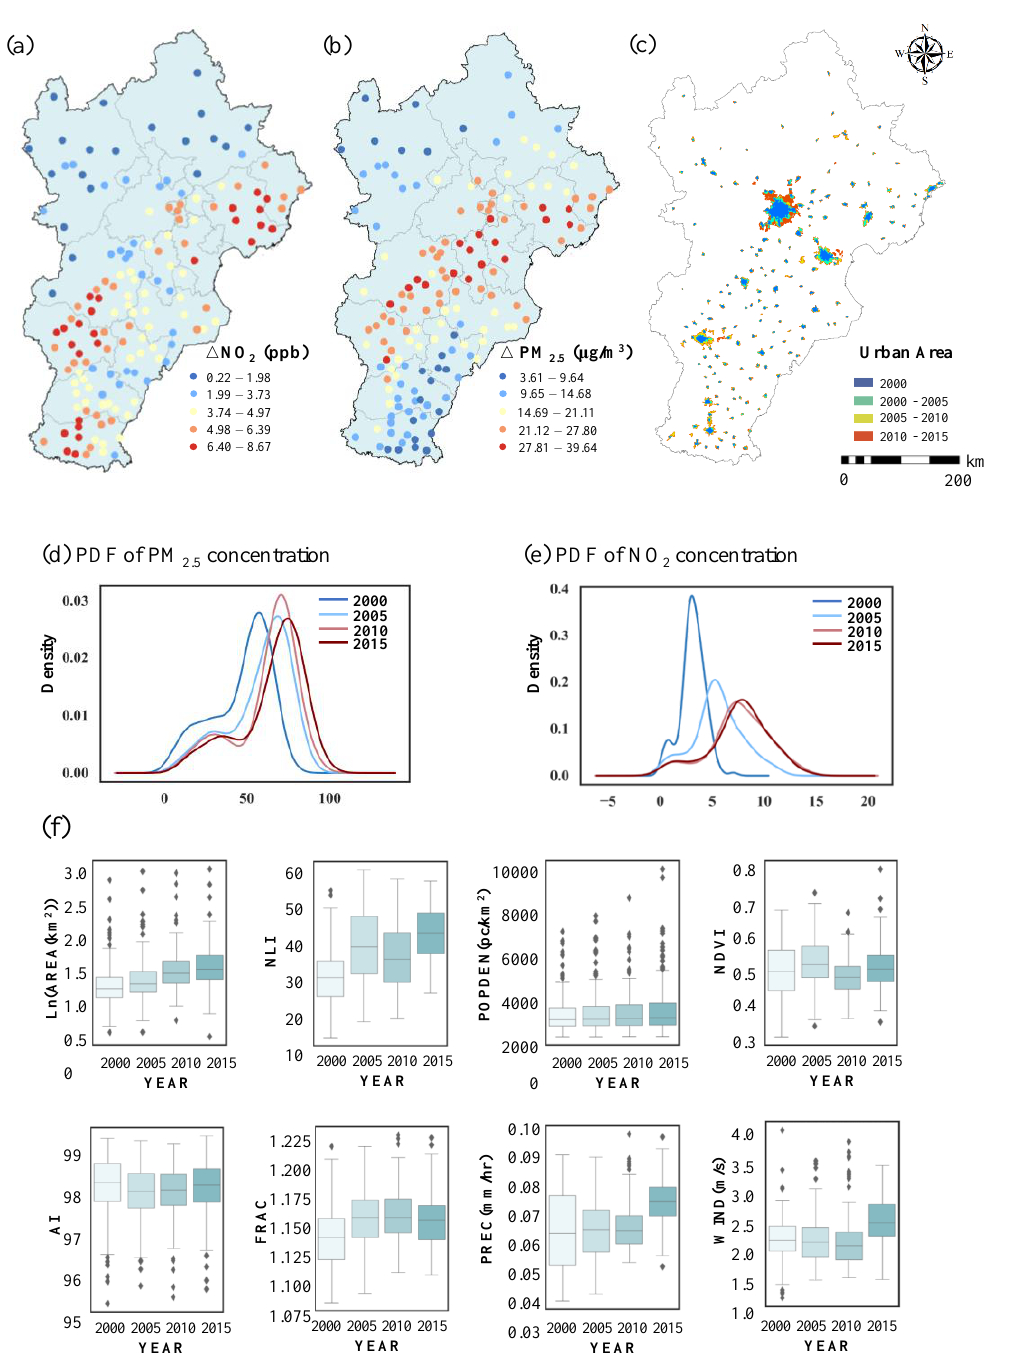
Figure 4. Changes of PM 2.5 ( a ), NO 2 concentration ( b ), and urban land ( c ) from 2000 to 2015 and probability density function (PDF) plot of air pollution levels (PM 2.5 in ( d ) and NO 2 in ( e )). ( f ) Boxplots of the urban form indicators (UFIs) from 2000 to 2015. The darker color of the boxplot means that the data are more recent. The whiskers encompass 1.5 of the interquartile range (IQR) above the third quartile and below the first quartile.